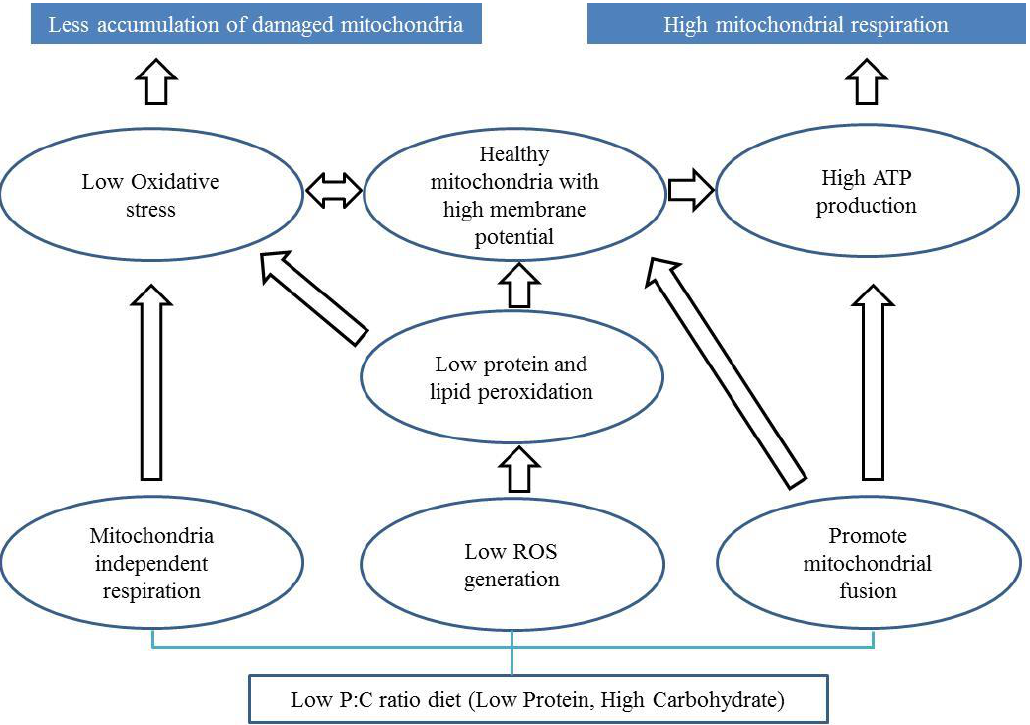
Figure 1. Potential mechanisms by which low protein and high carbohydrate diet can prevent mitochondrial dysfunction in Parkinson’s disease. Low P:C ratio diet can enable mitochondrial independent respiration causing low reactive oxygen species (ROS) generation which may lead to low oxidative stress. Low P:C ratio diet may also facilitate lower ROS generation preventing lipid peroxidation. Low P:C ratio diet can promote mitochondrial fusion and function. The bottom rectangle is the macronutrient (low P:C ratio diet). The ovals represent the potential mechanisms and processes of how macronutrients can affect mitochondrial functions. The top blue filled rectangles are the ways that can lead to healthy and efficient mitochondria in PD.